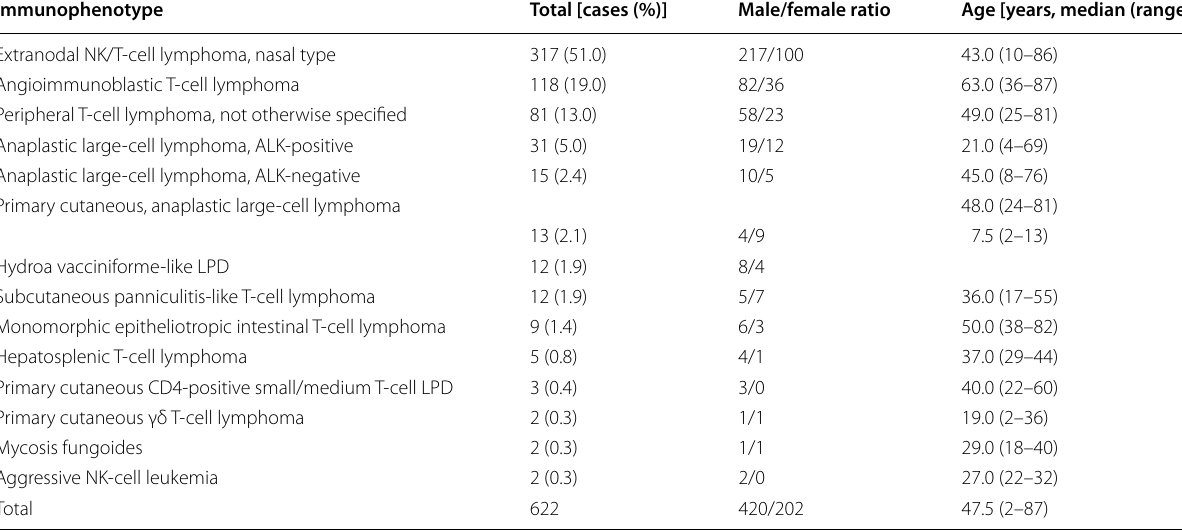
Table 2 Immunophenotype distribution in 622 cases of mature T-cell and NK-cell